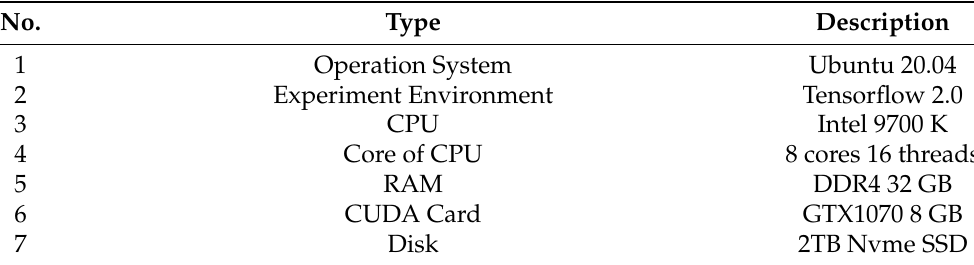
Table 5. Hardware and software